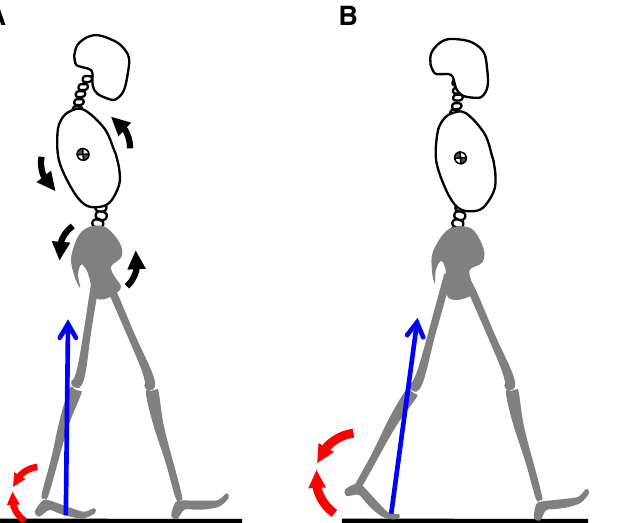
Figure 4. Comparison of the posture and kinetics during gait between the two groups. ( A ) Dropped head syndrome (DHS) group, backward leaning posture of the thorax with an increased ankle-joint dorsi-flexion angle. ( B ) Healthy group, upright posture with a decreased ankle-joint dorsi-flexion angle. Black arrows indicate the backward tilted thorax and pelvis. Blue arrows are the ground reaction force vector. Red arrow is the ankle- joint planter-flexion moment. DHS Dropped head